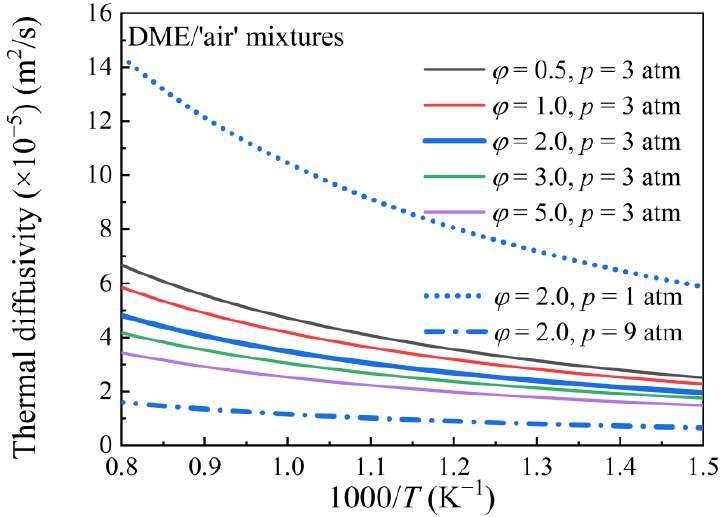
Figure 7. Thermal diffusivity of DME/‘air’ mixtures with varying equivalence ratios at different pressures.